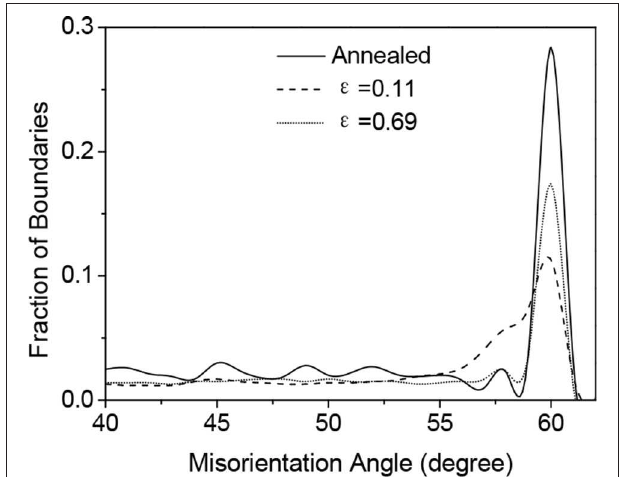
FIGURE 7 | DRX fraction vs. true strain by different methods.